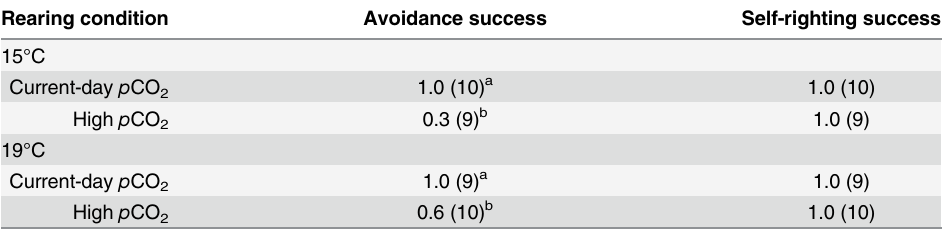
Table 4. Concholepas concholepas. Proportion of individuals displaying predator avoidance and self-right- ing behaviour. Number in parenthesis represents the sample size. The measurements were done after 3 month of rearing under contrasting conditions of p CO 2 and temperature. Proportion of avoidance success between p CO 2 levels within each rearing temperature were analyzed with a χ 2 test. Different superscripts indicate significant differences between treatments (p <